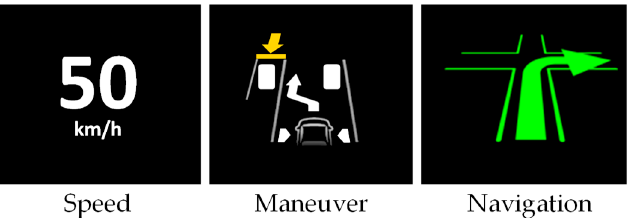
Figure 9. Head-up display showing speed, maneuver, and navigation information when the AV insists on the right of way in the road bottleneck scenario narrowed on both sides. The black background is transparent in the driving simulation.